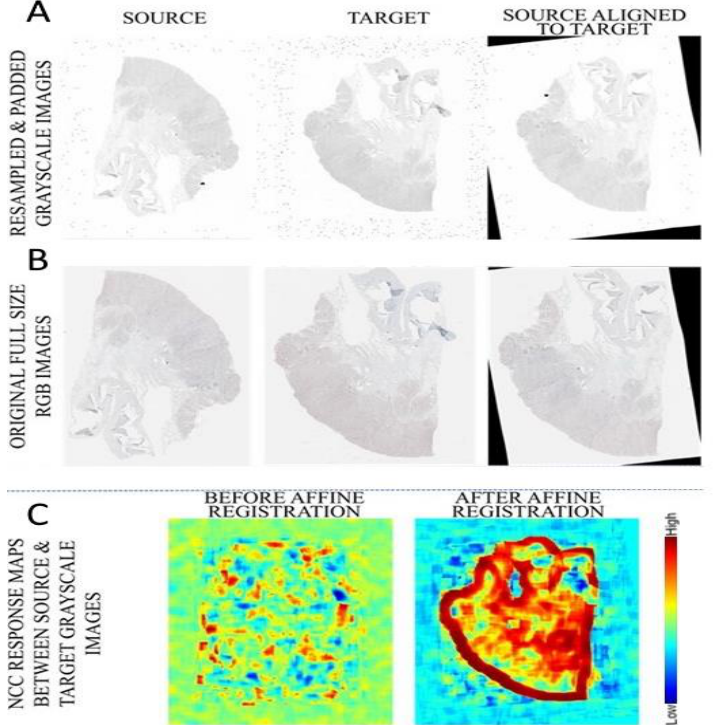
Figure 7. Example results of our affine registration step. ( A ) The affine registration estimated and applied on the resampled and padded images; ( B ) application of the registration applied to the original full-scale images; ( C ) the NCC response map between source and target before and after affine registration.